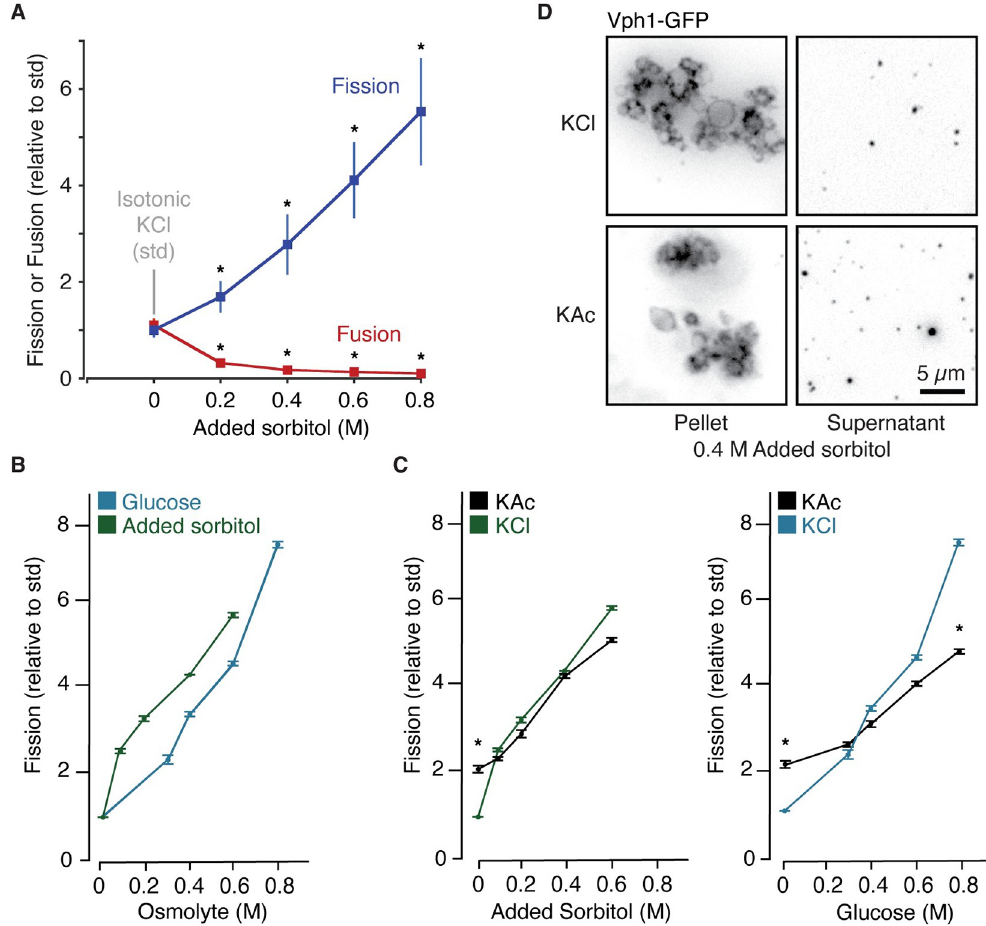
Fig 3. Effects of KAc and hypertonic stress on vacuole fission. (A) Homotypic fusion or fission of isolated vacuoles in the presence of KCl and increasing concentrations of sorbitol added to standard, isotonic conditions (which already contains 0.2 M sorbitol). (B, C) Fission of isolated vacuoles in the presence of either glucose or added sorbitol and 125 mM KCl (B) or KAc (C). Means ± S.E.M. shown and P < 0.05 ( � ) as compared to standard, isotonic conditions (125 mM KCl, 200 mM sorbitol). (D) Micrographs of fission reactions containing vacuoles isolated from Vph1-GFP expressing yeast cells conducted under hypertonic conditions (0.4 M added sorbitol) in the presence of 125 mM KAc or KCl. Supernatants (containing fission products) and pellets (containing large vacuoles) are